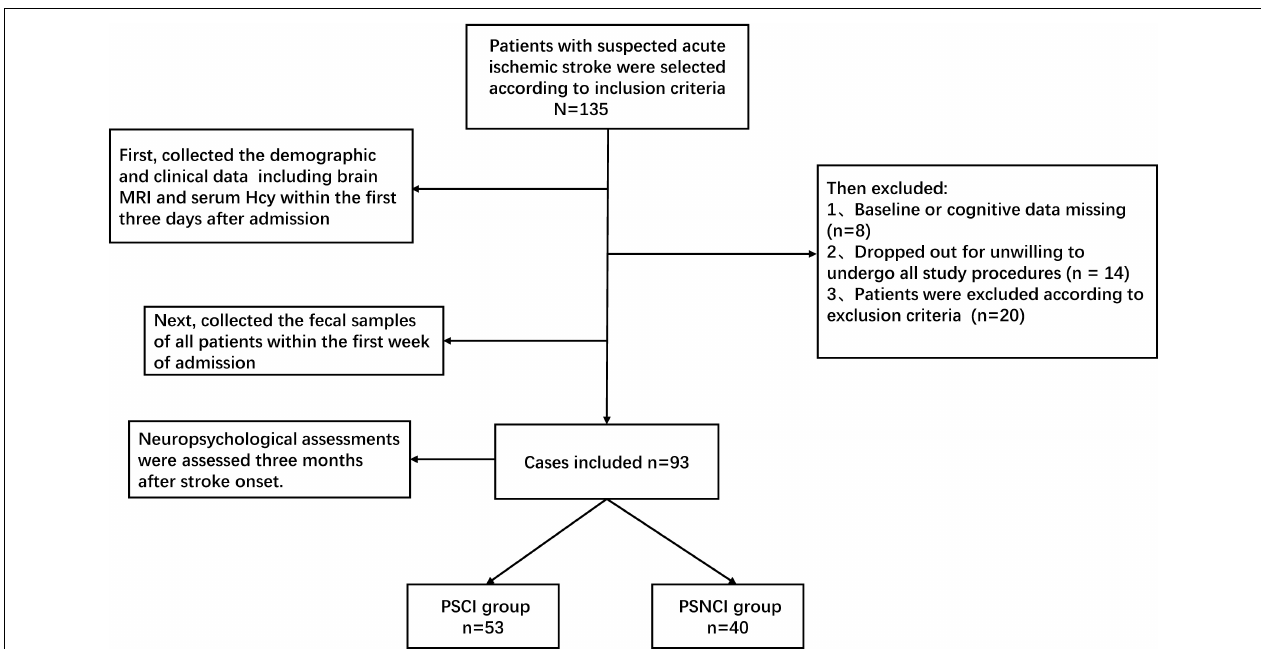
FIGURE 1 | Flowchart of patients included in this